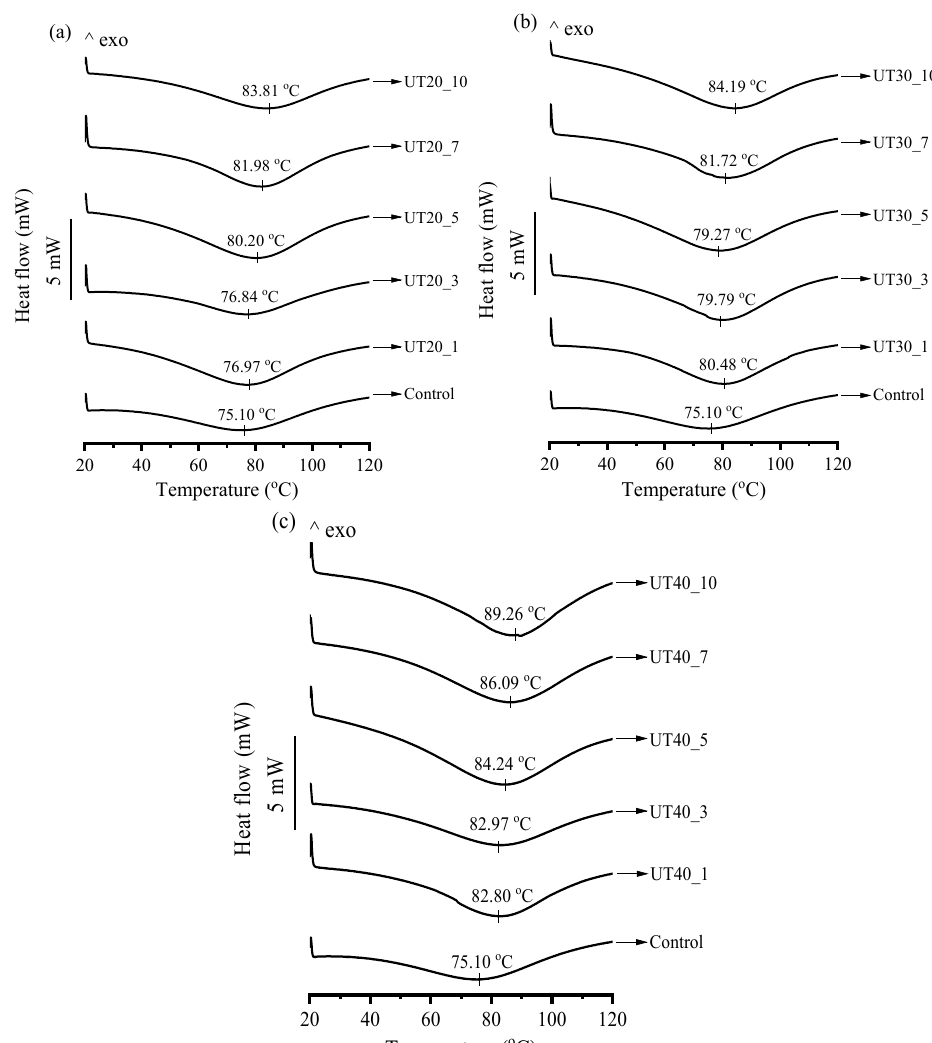
Figure 6. E ff ects of ultrasound treatment on Di ff erential Scanning Calorimetry (DSC) curves of goat Figure 6. Effects of ultrasound treatment on Differential Scanning Calorimetry (DSC) curves of goat milk β -lactoglobulin samples treated at di ff erent amplitudes (20% ( a ), 30% ( b ), 40% ( c )) and di ff erent milk β -lactoglobulin samples treated at different amplitudes (20% ( a ), 30% ( b ), 40% ( c )) and different treat times (0, 1, 3, 5, 7, 10 treat times (0, 1, 3, 5, 7, 10 min).